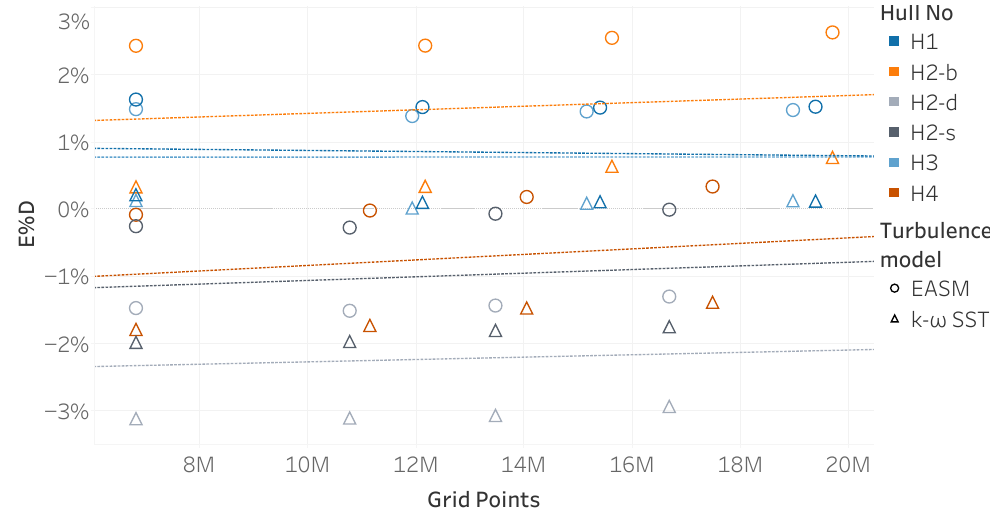
Figure 6. Comparison error of all test cases for the refinement region